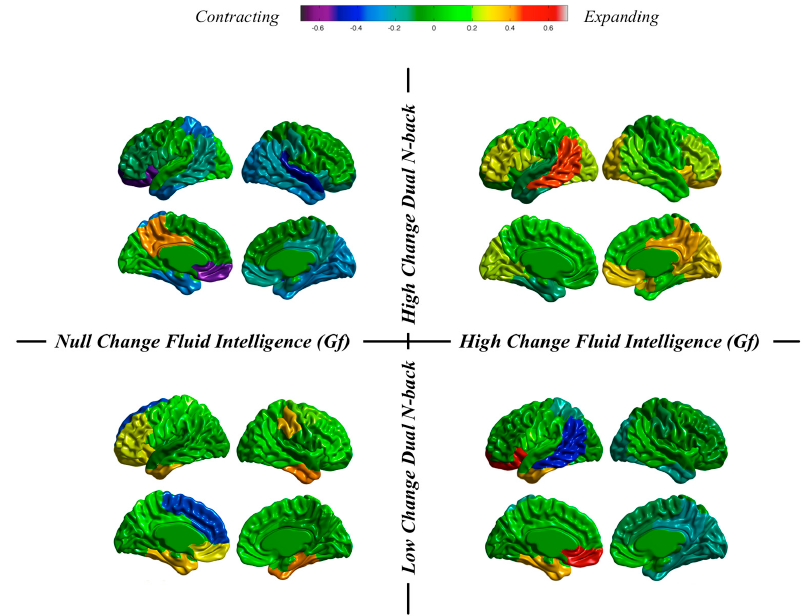
Figure 8. Surface area changes for individuals showing null changes in fluid ability and high changes in dual n-back ( top left ), high changes in fluid ability and high changes in dual n-back ( top right ), null changes in fluid ability and low changes in dual n-back ( bottom left ), and high changes in fluid ability and low changes in dual n-back ( bottom right ).